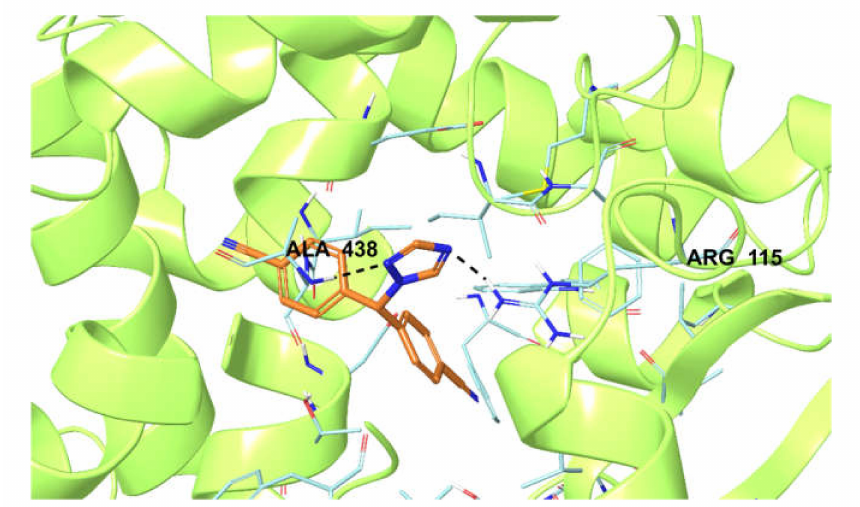
Figure 4. The interacting mode of letrozole in the active region of human aromatase. The inhibitor, colored with orange, and the important residues, colored with turquoise, in the active site of the enzyme are presented by tube